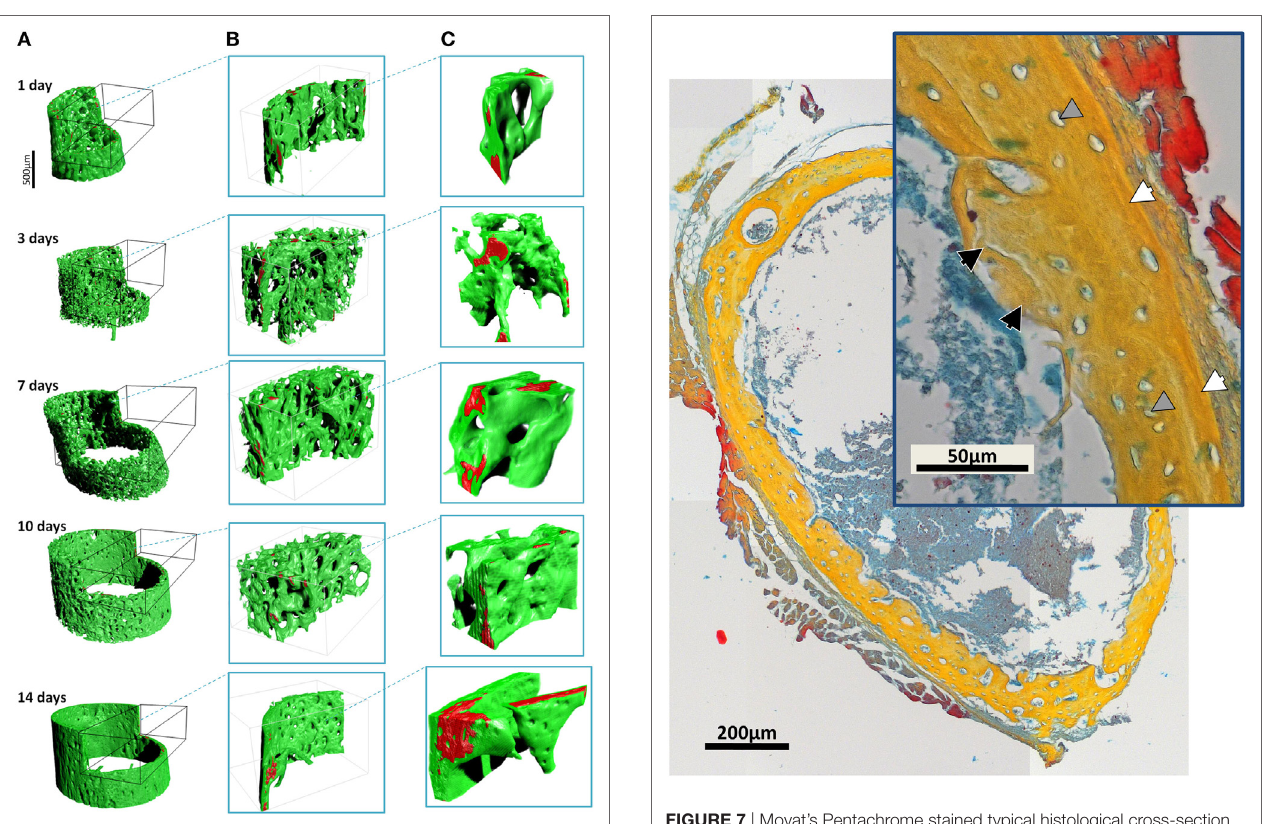
FigUre 7 | Movat’s Pentachrome stained typical histological cross-section of a paraffin-embedded 14-day-old mouse femur mid-diaphysis. Mineralized material is stained in yellow and can be clearly distinguished from the muscles (red) and the bone marrow (shades of blue). The inset shows a magnified region of the bone cortex. Regions of woven bone (black arrows) are seen on the endosteal surface, and lamellar bone (white arrows) is located on the periosteal region. Osteocyte lacunae can be detected (gray arrowheads).